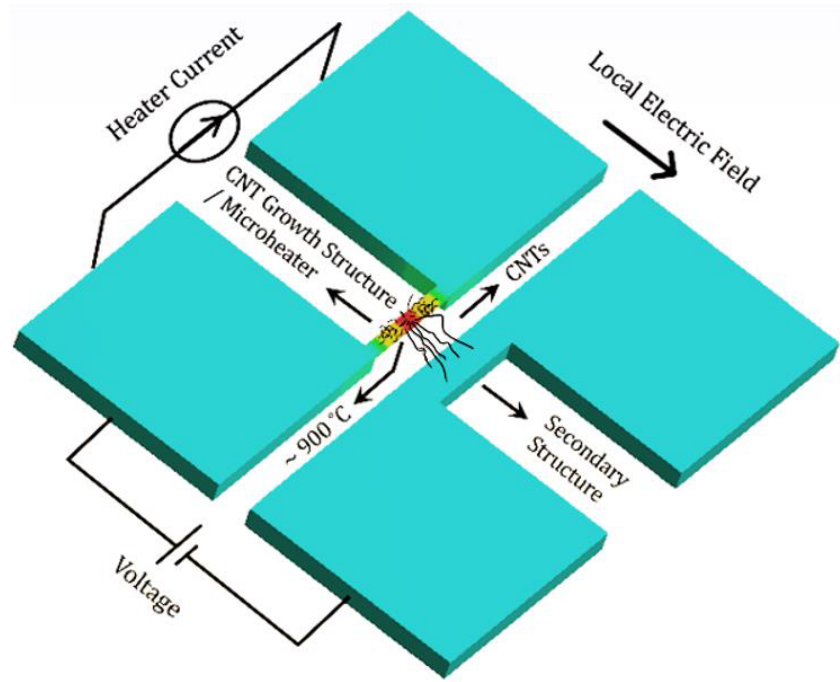
Figure 1. Concept illustration of local carbon nanotubes (CNT) synthesis on microstructures.